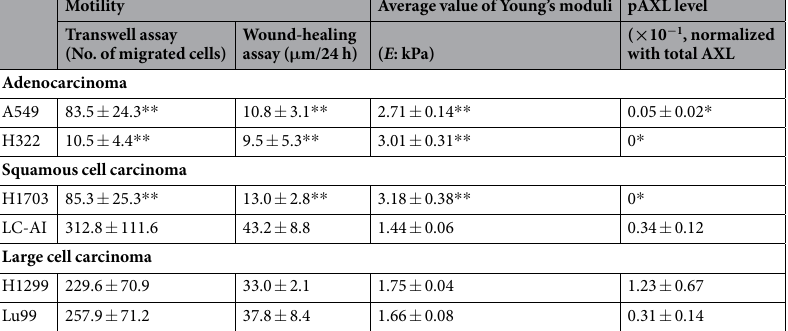
Table 1. Motility, cell stiffness and pAXL level in six lung cancer cell lines. A549, H322, and H1703 cells belong to LMHS group, and LC-AI, H1299, and Lu99 cells belong to HMLS group. “ * ” indictes statistical differences between LMHS and HMLS groups. * p < 0.05, ** p <